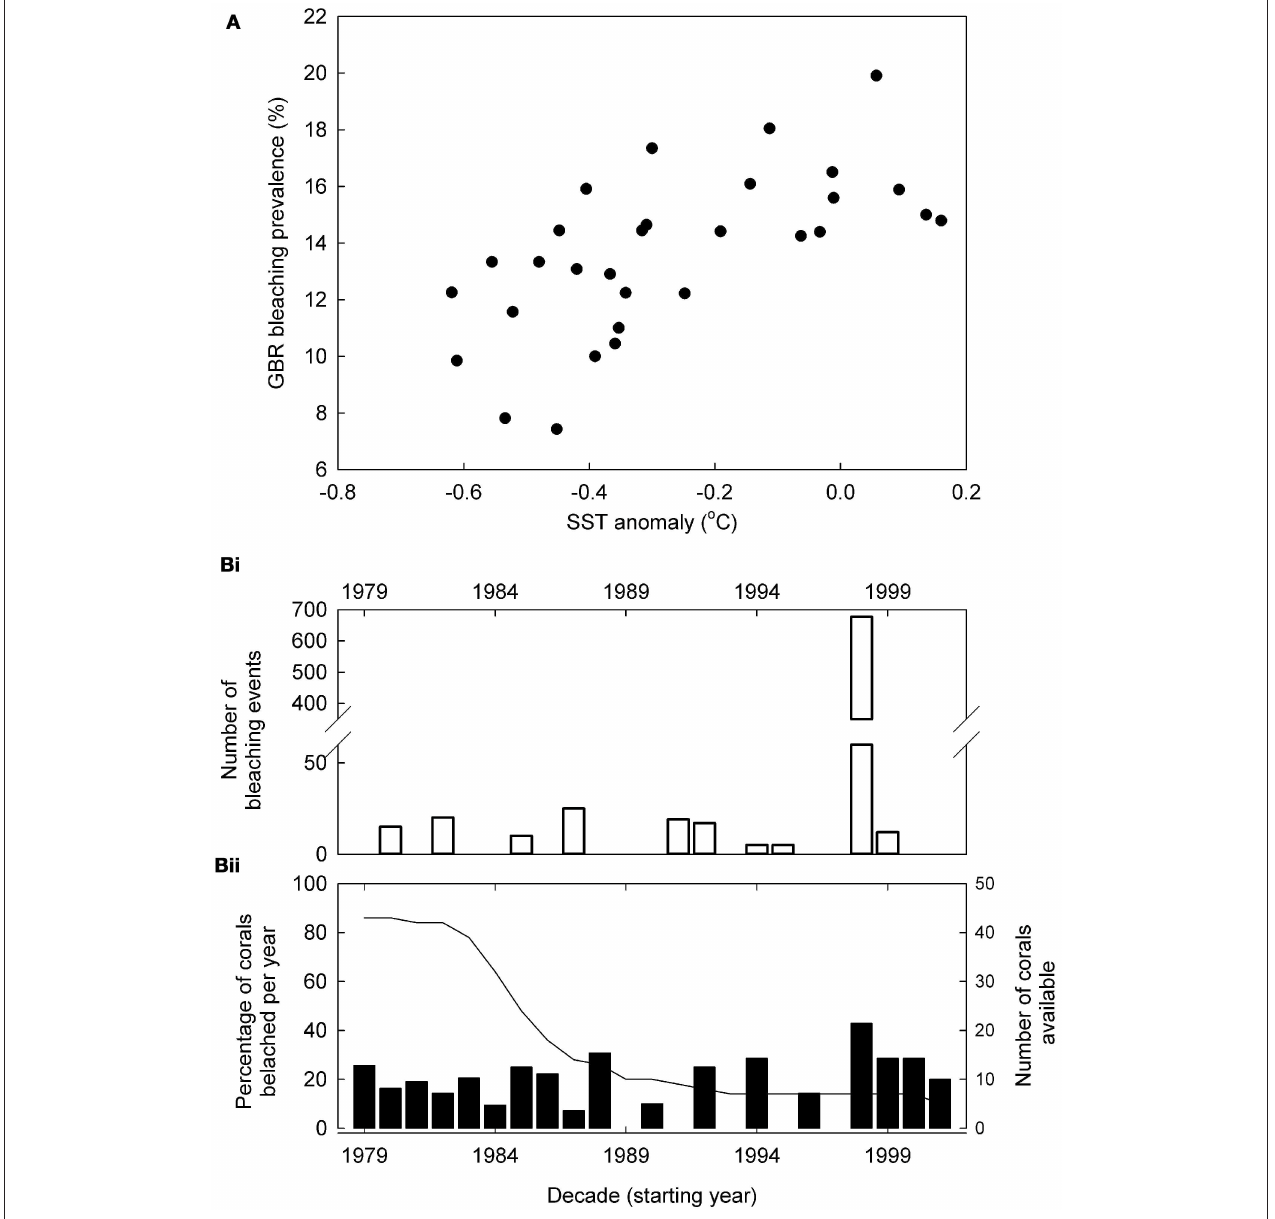
FIGURE 3 | Reconstructed bleaching compared to other records. (A) Bleaching prevalence—temperature responses; decadally binned Great Barrier Reef (GBR) reconstructed bleaching prevalence responses to reconstructed western Pacific (Tierney et al., 2015) sea surface temperature (SST) between 1700 and